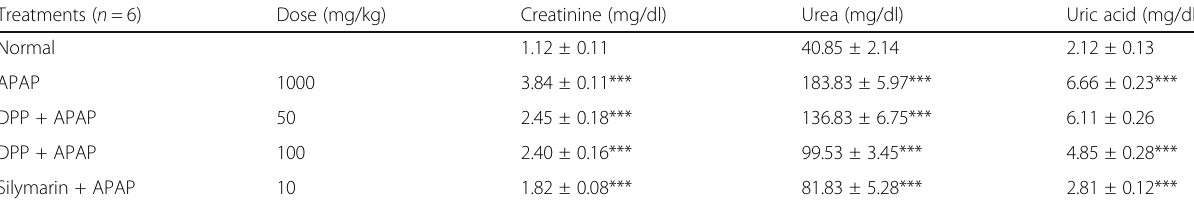
Table 3 Effect of DPP on APAP-intoxicated rats serum creatinine, urea, uric acid Treatments ( n = 6) Dose (mg/kg) Creatinine (mg/dl)